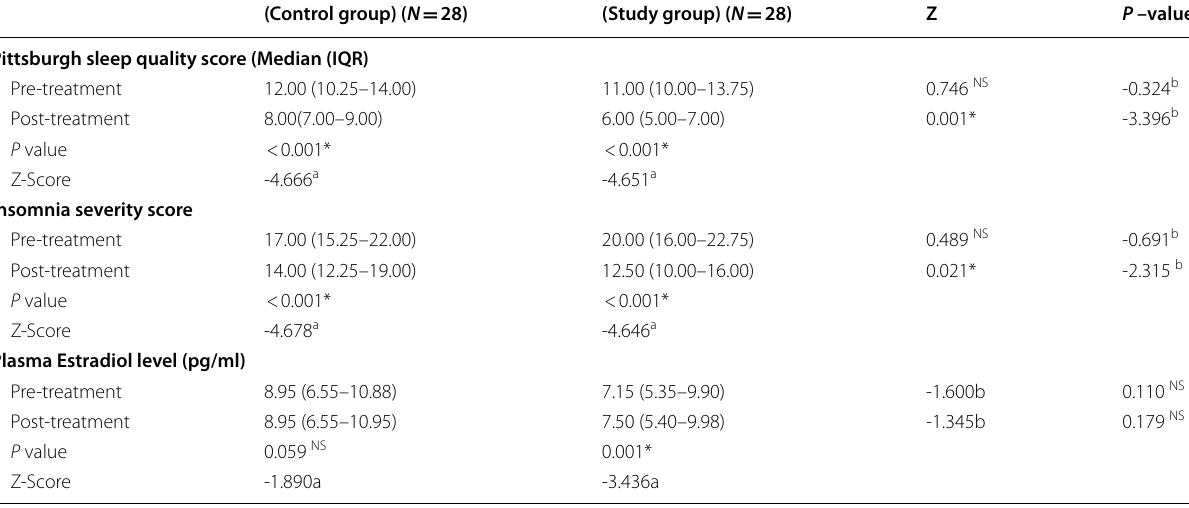
Table 2 Comparison of Pittsburgh sleep quality, insomnia severity score, and plasma estradiol level pre- and post-treatment in control and study groups